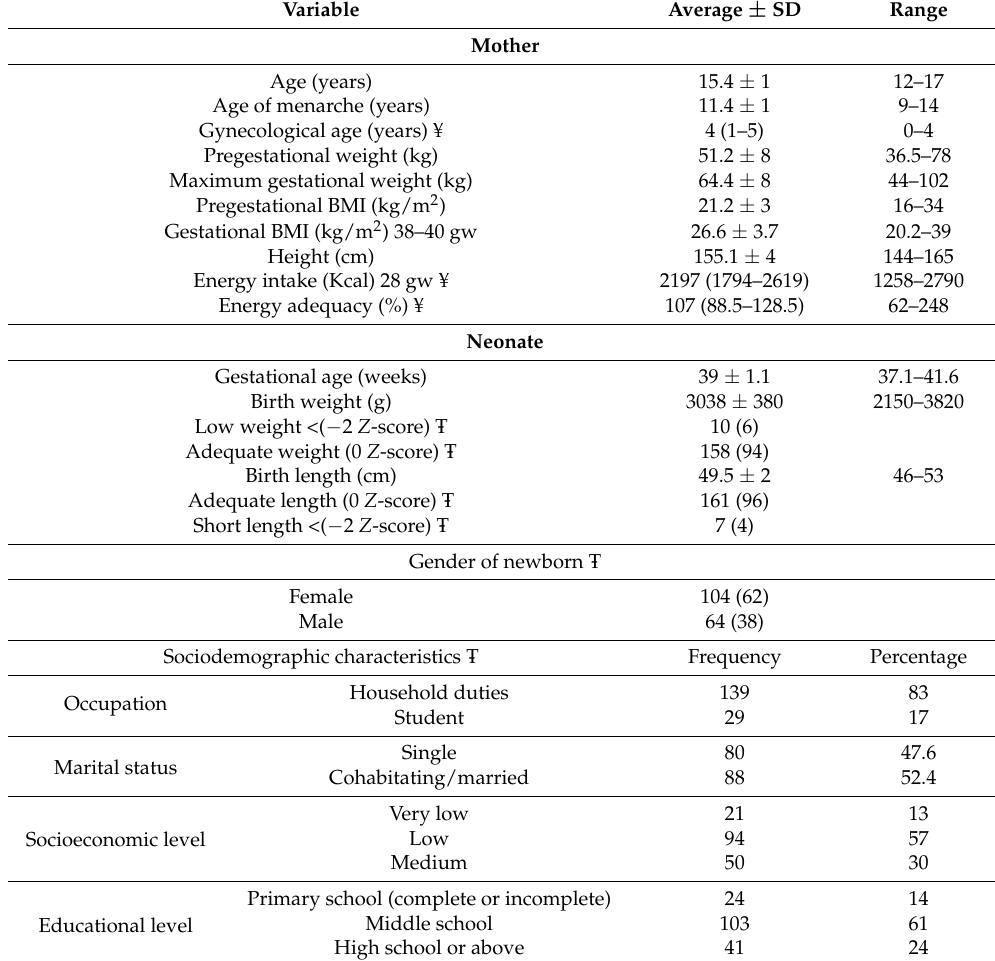
Table 1. General characteristics of the participating adolescent mothers ( n = 168).